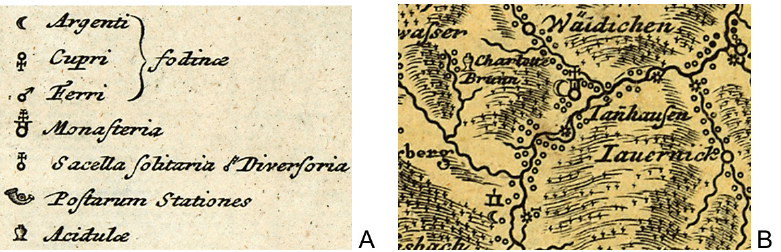
Fig. 4. A – a part of the legend, B – a part of the map Principatus Silesiae Schwidnicensis (Duchy of Świdnica), 1750 (the collection of the National Library of Poland in